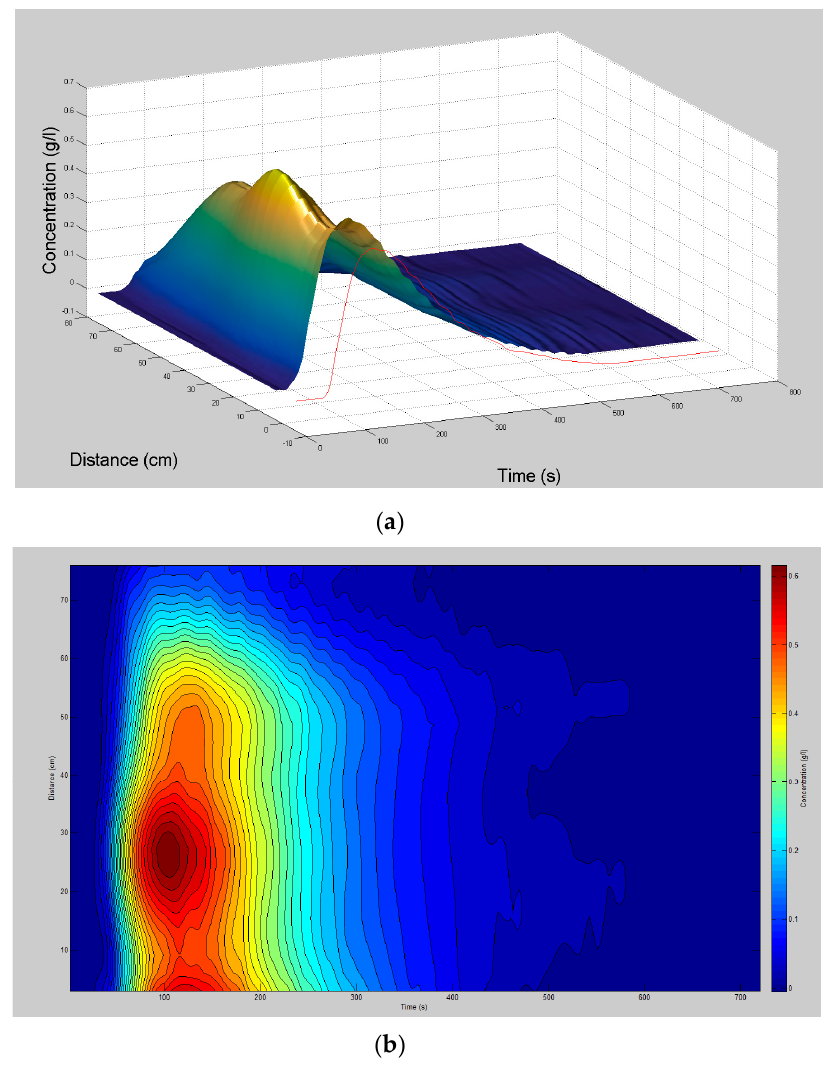
Figure 1. The tumor microenvironment (TME) heterogeneously consists of cellular and non-cellular components including the surrounding blood vessels, immune cells, fibroblasts, cancer stem cells and extracellular matrix (ECM).